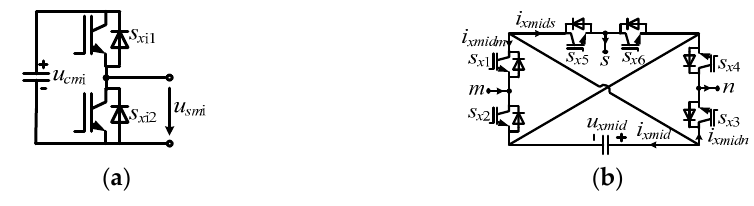
Figure 2. SM structure. ( a ) Half bridge-based SM. ( b ) Proposed middle cell.